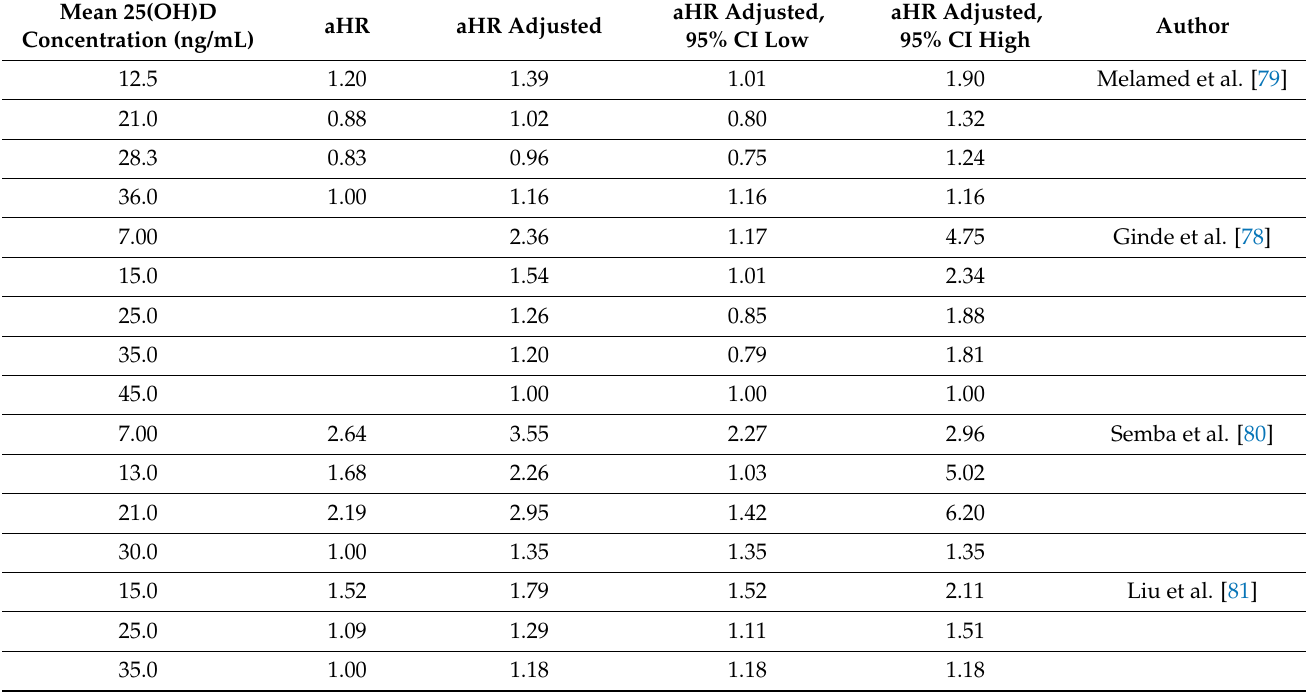
Table 2. Data on mean 25(OH)D concentration and aHR for CVD mortality extracted from four research articles as further adjusted as just discussed